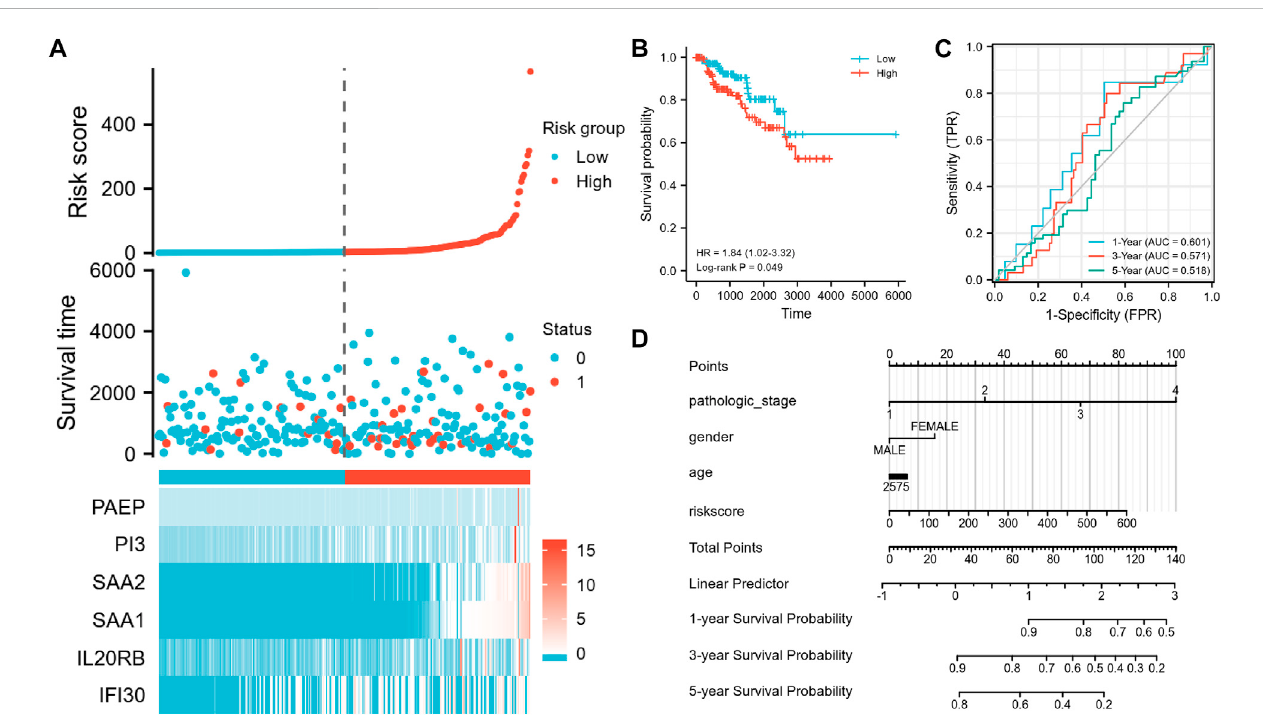
FIGURE 9 Validation of the IRSS signature with the TCGA-KIRP dataset. (A) Risk scores, survival status, and heat maps of the six immunity-related genes in KIRP patients. (B) Kaplan-Meier curve exhibited signi fi cant differences in OS between the high- and low-risk groups in TCGA-KIRP. (C) Time-dependent ROC curvesforpredicting1-,3-and5-yearsurvivalrates. (D) 1-,3-,and5-yearnomogramsforpredictingOSinpatientswithKIRP.Thisnomogramincorporatesthe following four variables: Age, gender, pathology stage, and IRSS. 0 represents the survival status “ alive ” and one represents the survival status “ dead.